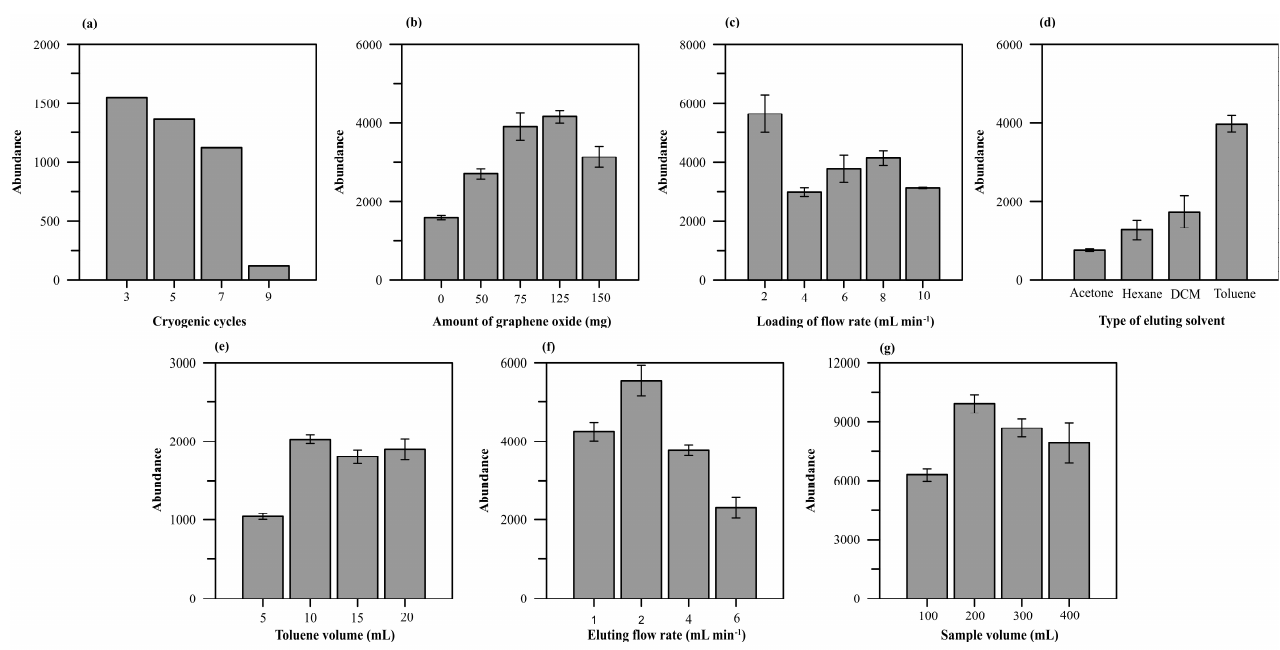
Figure 2. Influence of ( a ) cryogenic cycles, ( b ) amount of GO, ( c ) loading flow rate, ( d ) type of eluting solvent, ( e ) toluene volume, ( f ) eluting flow rate, and ( g ) sample volume on BaP response.